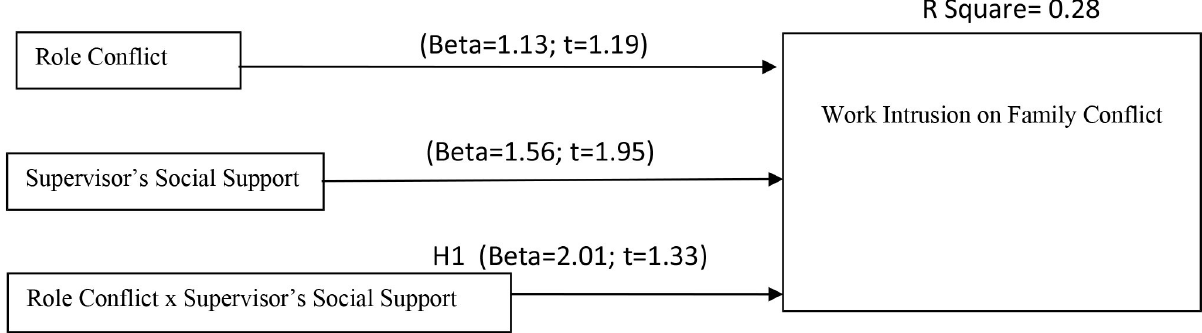
Figure 3. The Results of SmartPLS Path Model Showing the Moderating Effect of Supervisor’s Social Support in Between Role Conflict and Work Intrusion on Family